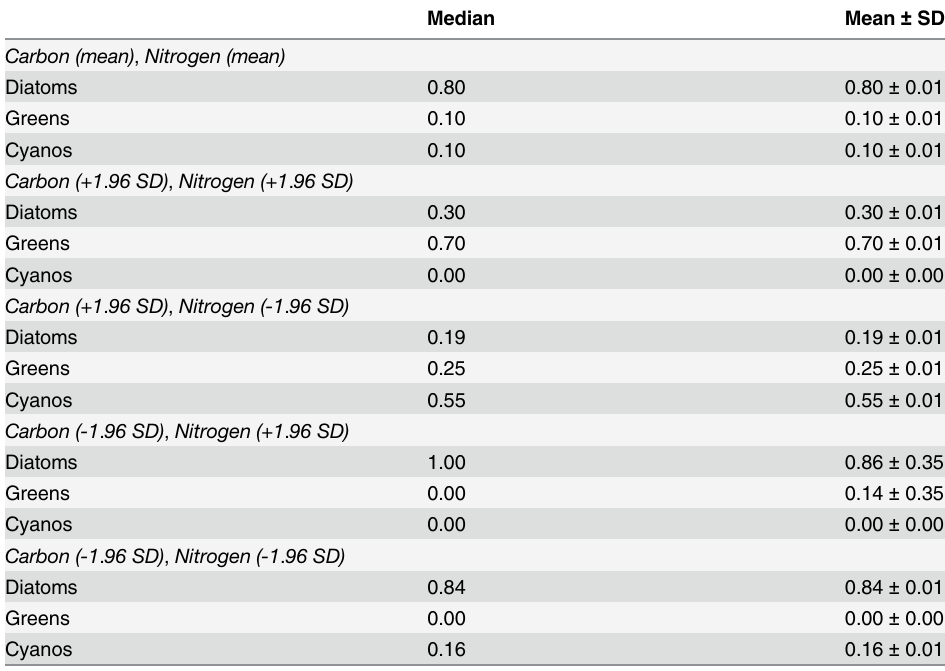
Table 2. A sensitivity analysis of the influence of the carbon and nitrogen fractionation assumptions on MixSIR SI based